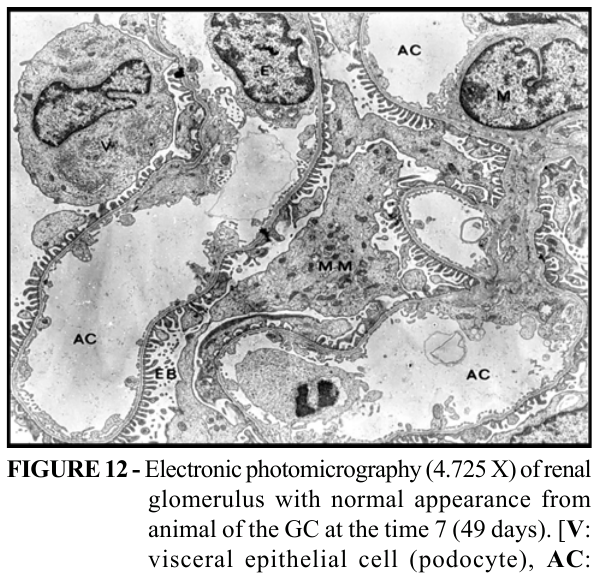
FIGURE 12 - Electronic photomicrography (4.725 X) of renal glomerulus with normal appearance from animal of the GC at the time 7 (49 days). [ V : visceral epithelial cell (podocyte), AC : Capillary loop, MM : Mesangial matrix, E : Endothelial cell, EB : Bowman’s space, M : Mesangial